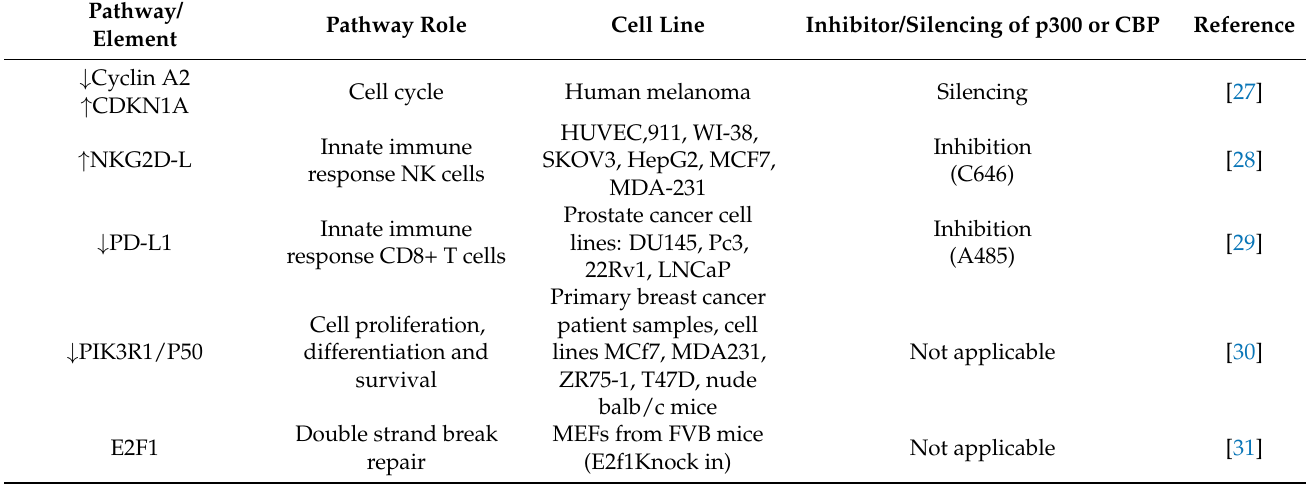
Table 1. Involvement of P300/CBP HAT in cellular